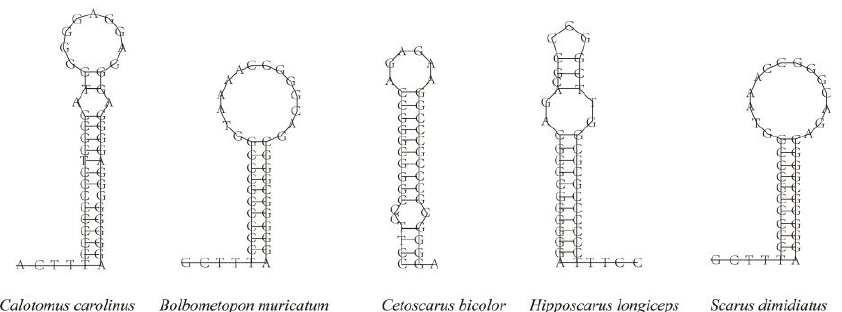
Figure 5. Putative secondary structure of the origin of L strand replication (O L ) in five parrotfish species.